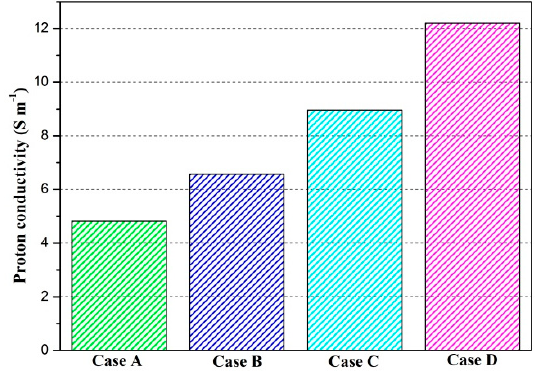
Figure 9. Proton conductivity of the membrane of four cases (Case A: DL = 5; Case B: DL = 7; Case C: DL = 9; Case D: DL = 11).